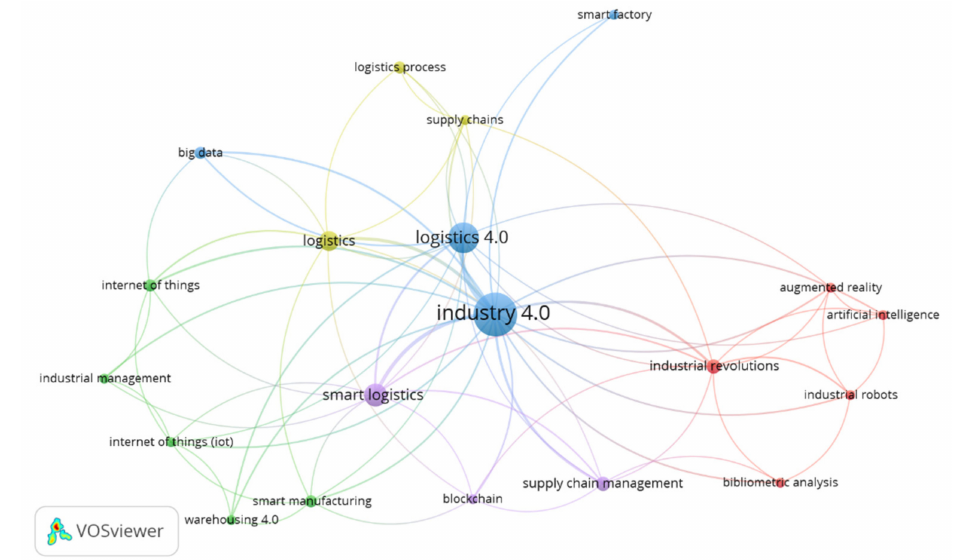
Figure 6. Keywords